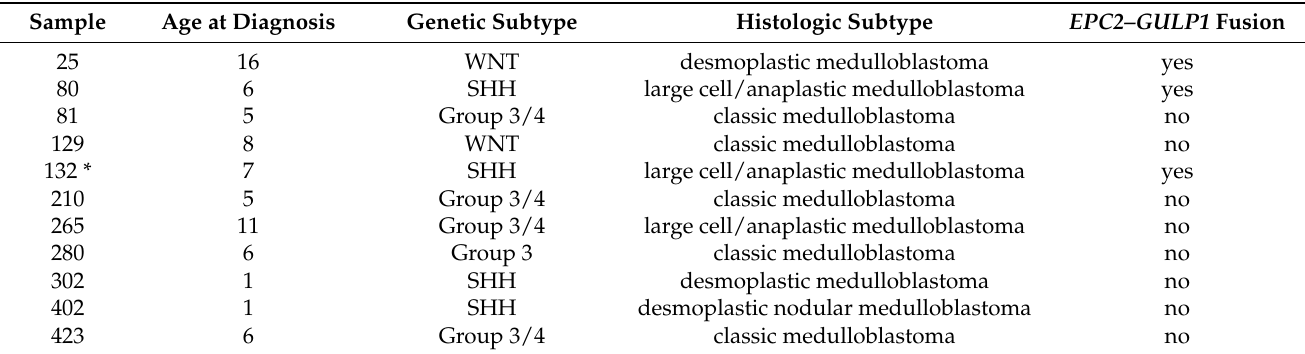
Table 2. Overview of medulloblastoma samples analyzed in this work.